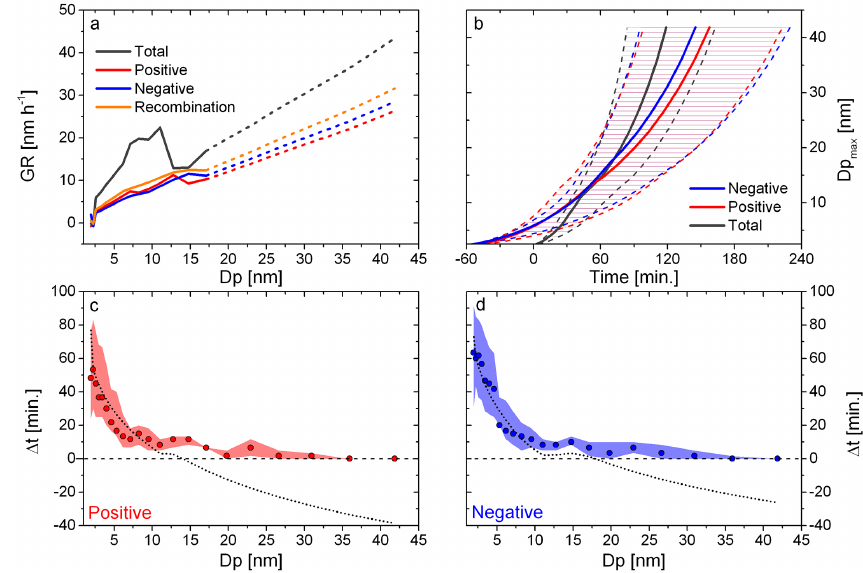
Figure 7. Median evolution of ions and particles for four NPF events with 1t >20min. (a) GR for total, positive, negative and recombined particles. (b) Time evolution of the growing modes ( Dp max ) of negative, positive and total particles, respectively. Hatched areas denote the 25th and 75th percentiles. (c, d) Time difference ( 1t ) for negative and positive ions, respectively. Dotted black lines are time differences calculated from the negative and positive growing mode to the total one, in principle this is the difference between the three Dp max -values from section b).